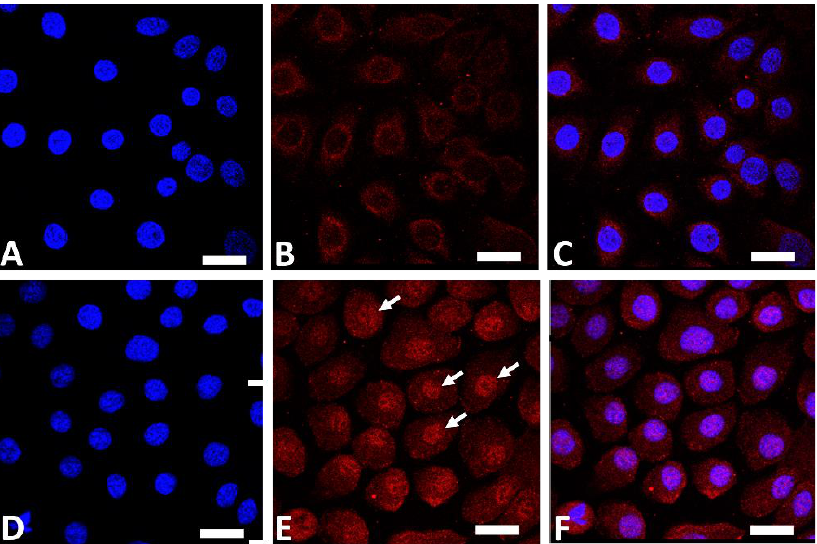
Figure 1. Immunofluorescence staining of AHR (red fluorescence) in human keratinocytes. Nuclei were stained with 4′,6 -diamidino-2-phenylindole (DAPI). Nonstimulated control keratinocytes (( A ); DAPI staining, ( B ); AHR staining, ( C ); merged). GFF-treated keratinocytes (( D ); DAPI staining, ( E ); AHR staining, ( F ); merged). AHR resides mainly in the cytoplasm in nonstimulated keratinocytes ( B ). GFF induces nuclear translocation of AHR (( E ), arrows). AHR: aryl hydrocarbon receptor. GFF: Galactomyces ferment filtrate. Bar; 25 μm.